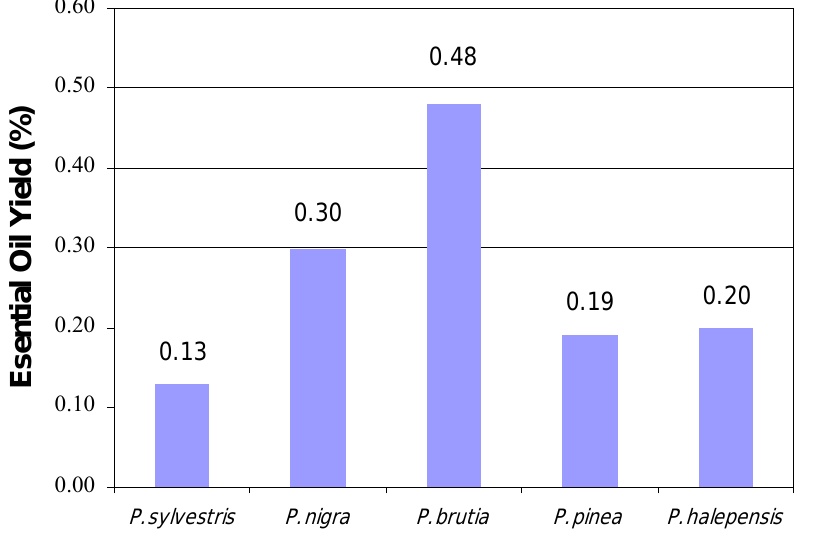
Figure 1. Essential Oil Yields of Pine Species from Turkey (%).